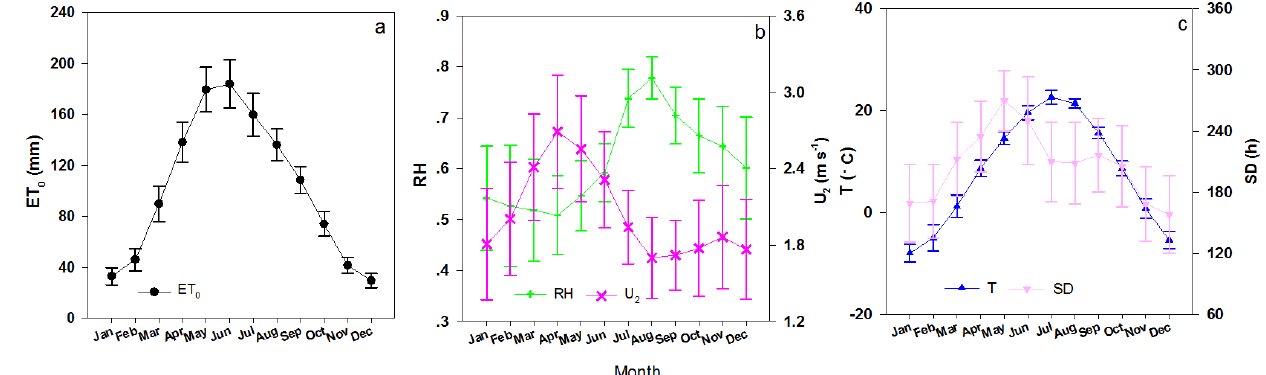
Figure 3. The seasonal pattern of ET 0 and meteorological variables of T , RH, U 2 and SD with one standard deviation.